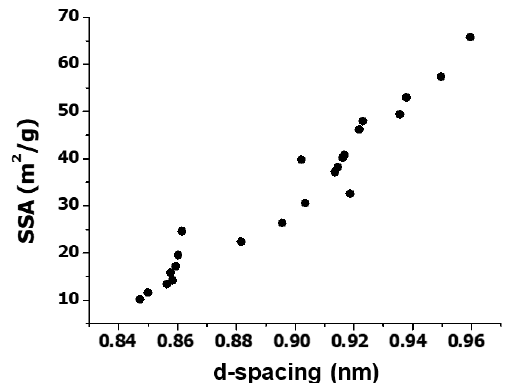
Figure 4. Specific surface area (SSA) vs. d-spacing for the synthesized EGOs.